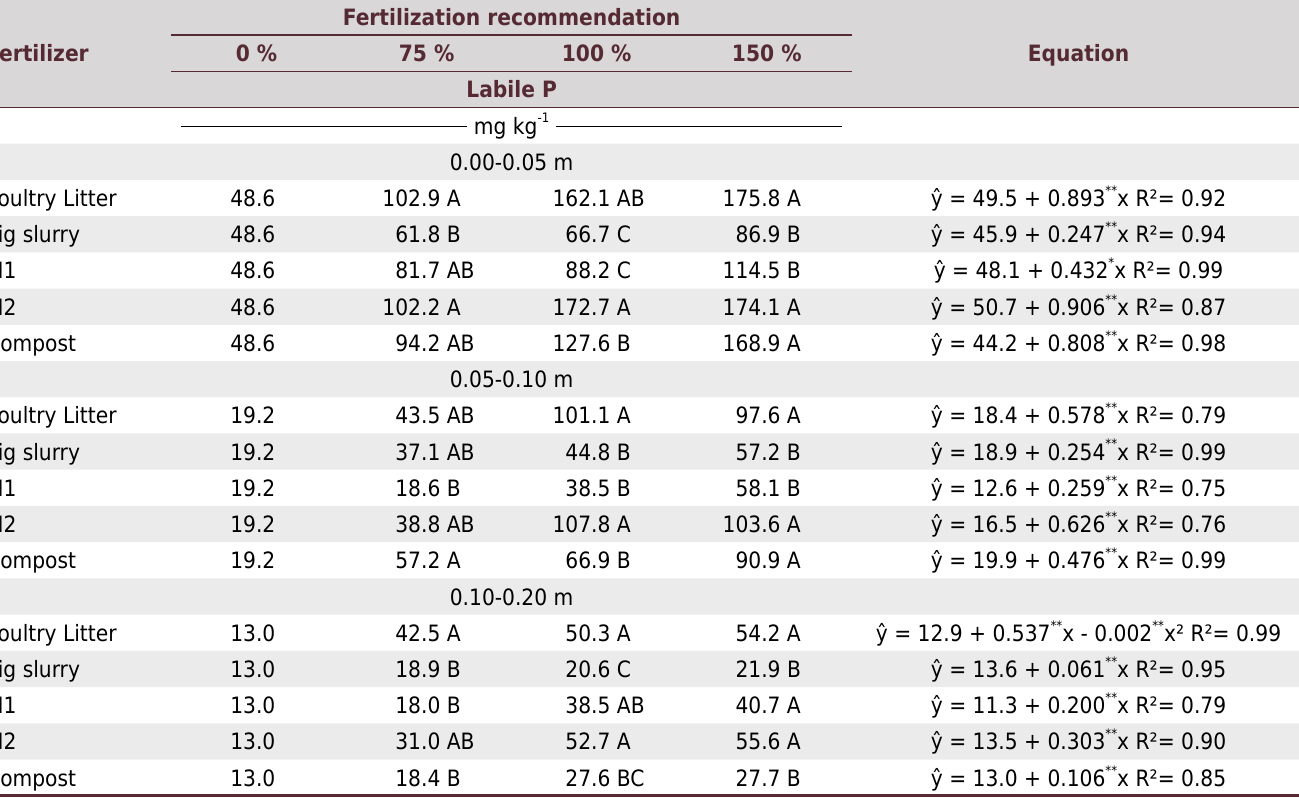
Table 3. Labile soil phosphorus fraction extracted by ionic exchange resin in the 0.00-0.05, 0.05-0.10, and 0.10-0.20 m layers after six years use of organic and mineral fertilizers in a Rhodic Kandiudox